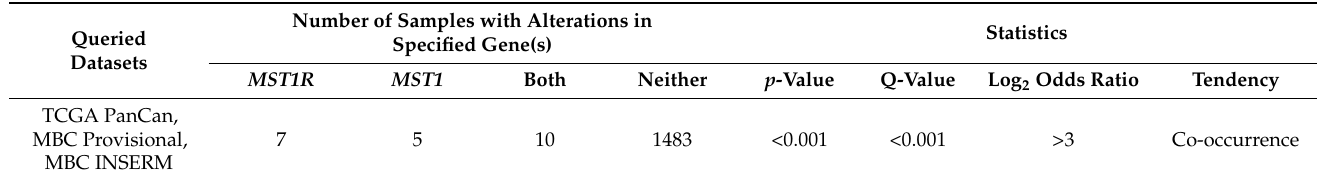
Table 1. Genetic/genomic alterations affecting MST1R and MST1 are rare but co-occur. Specified datasets available on cBioPortal were queried for MST1R and MST1